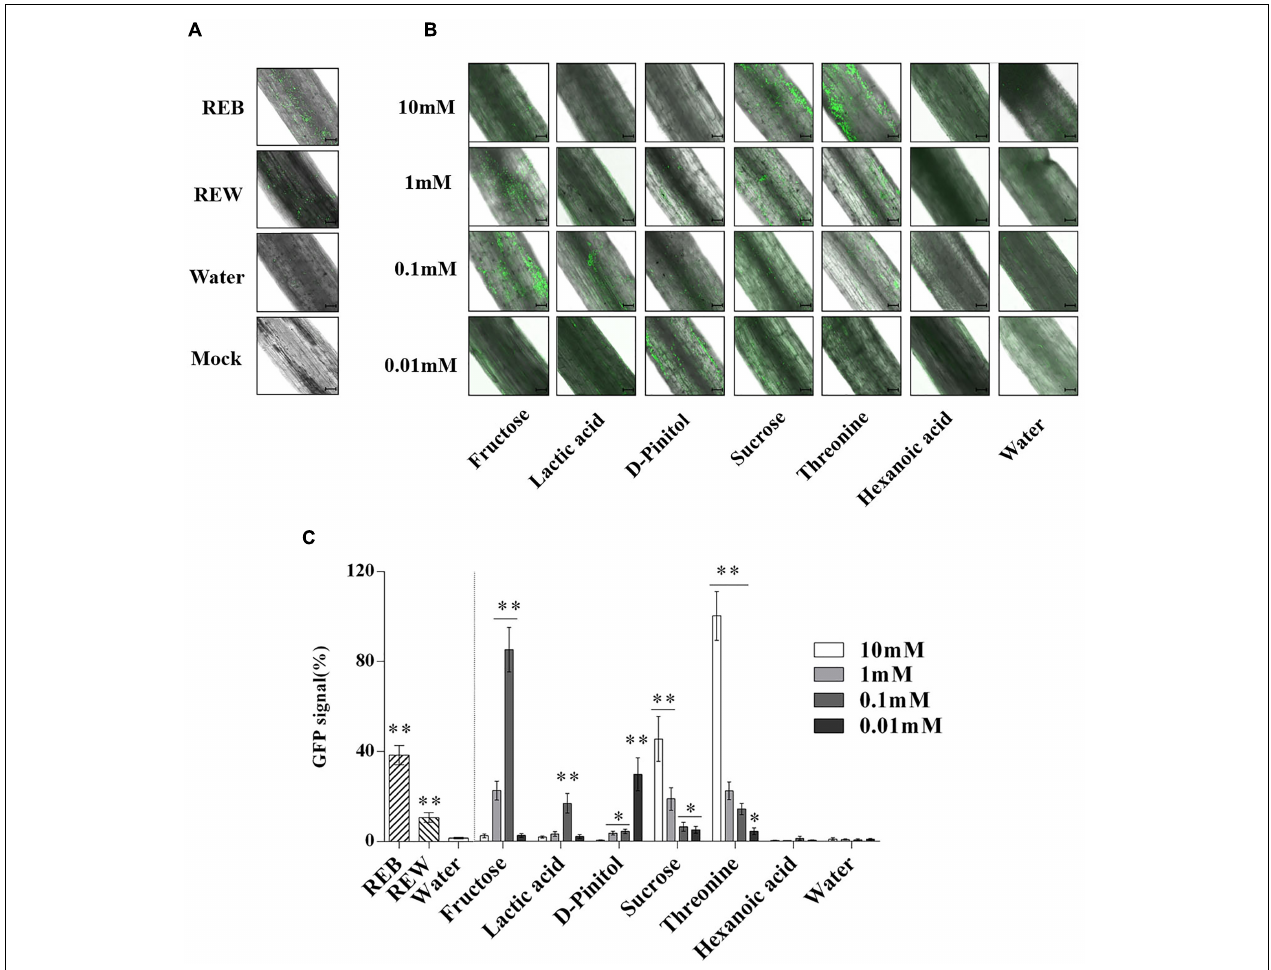
FIGURE 9 | Attachment of GFP-targeted Bacillus cereus AR156 strain on tomato root surface. Cells of Bacillus cereus AR156 form different colonization on the surfaces of excised tomato roots in 1% MS liquid medium containing tomato root exudate induced by Bacillus cereus AR156 (REB), tomato root exudate induced by water (REW) (A) or different components from tomato root exudates induced by B. cereus AR156 (B) at 25 ◦ C for 3 days and were visualized by Confocal Laser Scanning Microscope. Mock showed tomato root grown in absence of B. cereus AR156 cells. Scale bars = 100 µ m. The results in (A,B) were quantified in (C) . GFP signal was quantified using the Confocal Laser Scanning Microscope software (Leica AF6000 Modular microsystems) by measuring the total GFP fluorescence in one field inside the infiltration area with a low magnification objective (20X); all images used for fluorescence measurement were taken with the same settings. Basal signal measured in mock was subtracted from the values measured for each experimental condition, and the signal obtained with 10 mM Threonine was set as 100%. The mean and standard error values of three biological replicates are reported for each treatment. Asterisks in (C) indicate statistical significance difference between data of treatments and data of sterile water as determined by the Student’s t -test ( ∗ P < 0.05, ∗∗ P < 0.01). The experiment was carried out three times and one representative experiment is